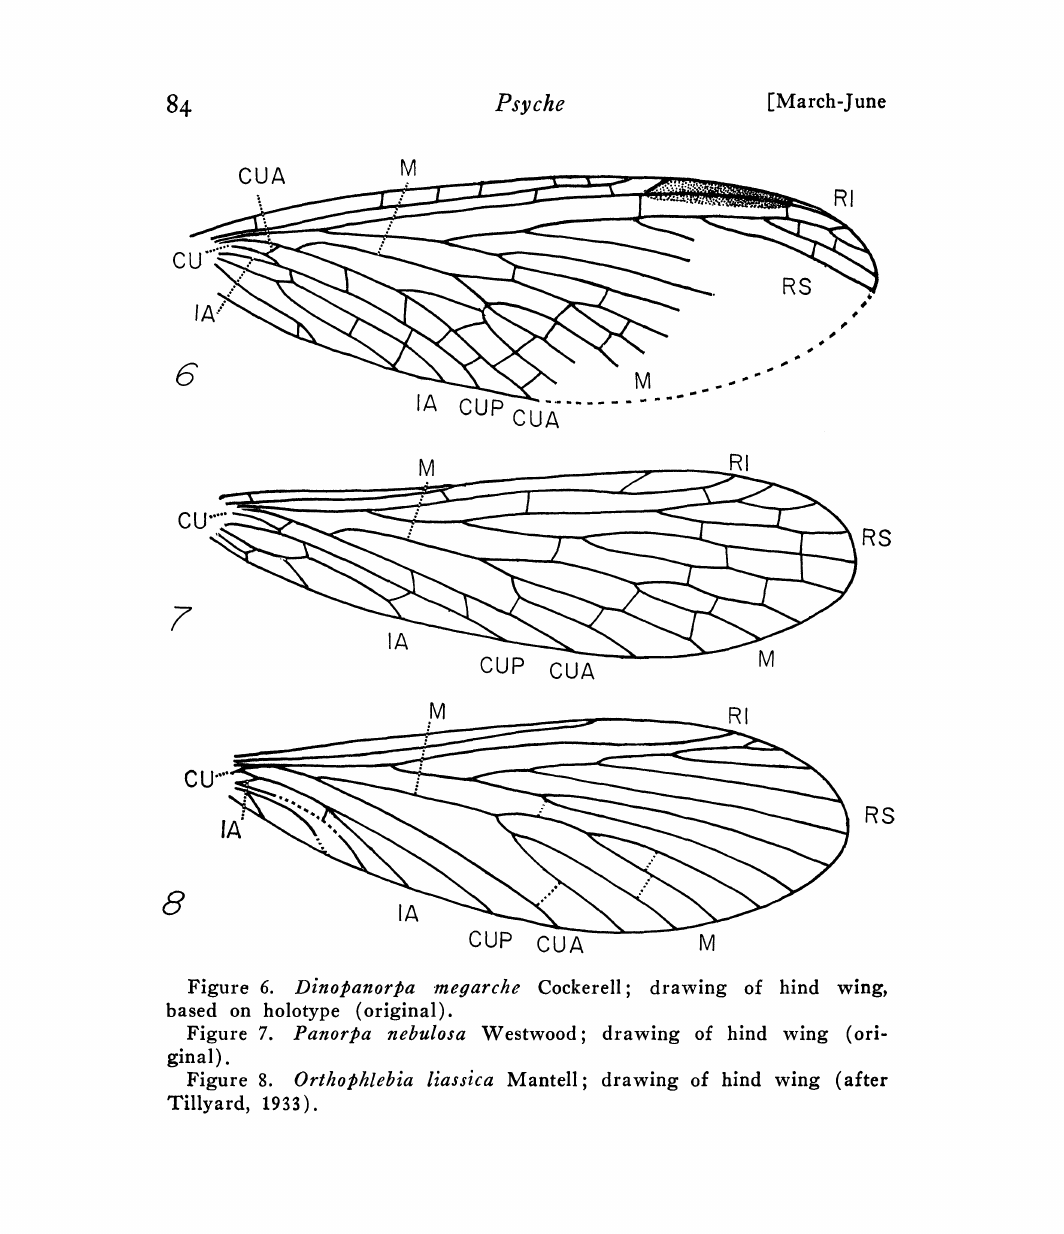
Figure 6. Dino#anor#a me#arche Cockerell; drawing of hind wing:, based on holotype (original). Figure 7. Panor#a nebulosa Westwood; drawing of hind wing (ori- ginal). Figure 8. Ortho#hlebia liassica Mantell; drawing of hind wing (after Tillyard,